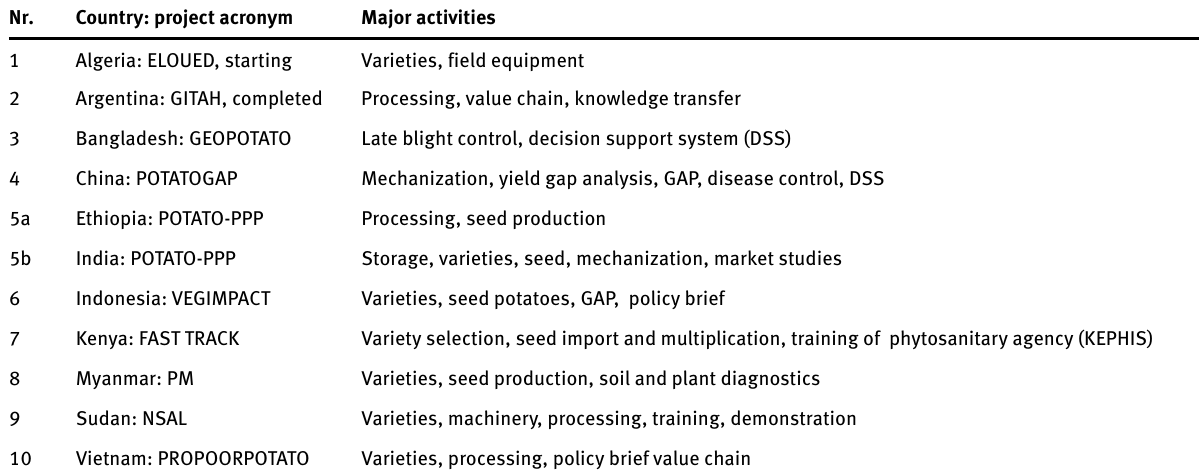
Table 4: Major activities in the Netherlands PPP potato projects 2012-2016